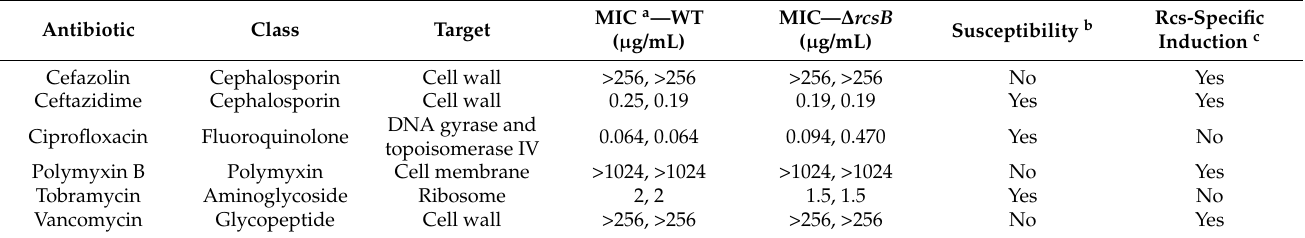
Table 2. Antibiotic susceptibility analysis of S. marcescens strain